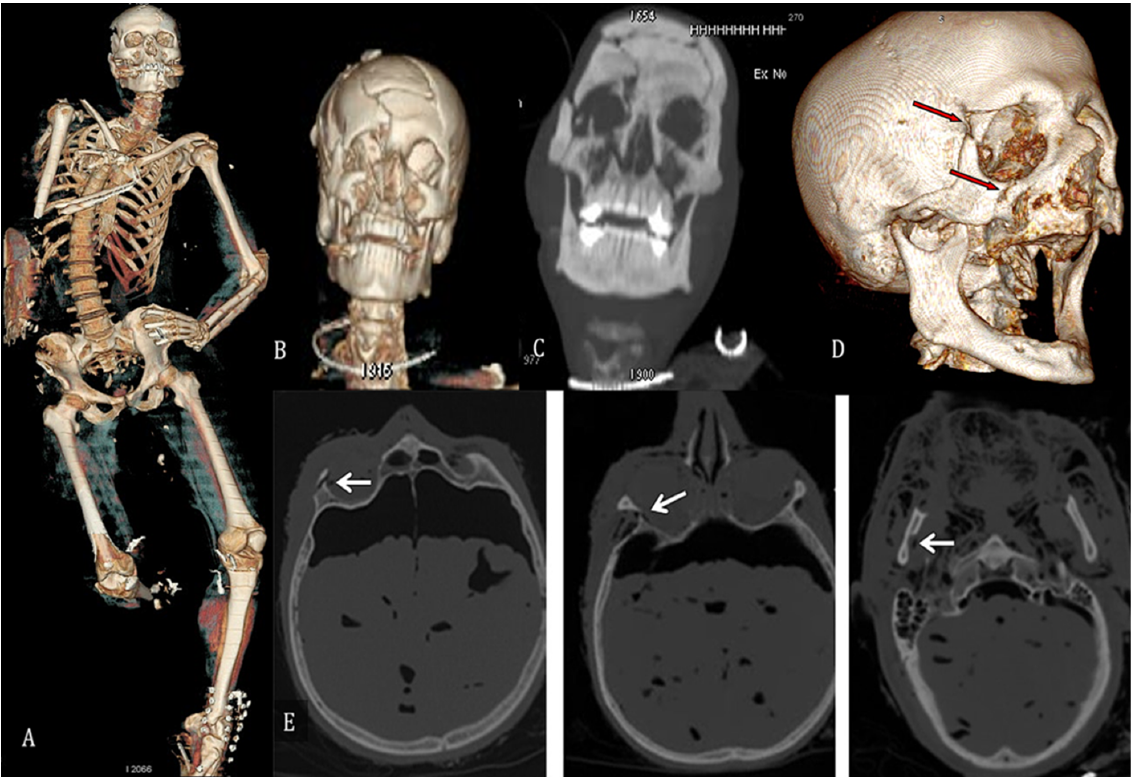
Figure 7. ( A ) Total body CT reconstruction on a partially charred corpse with the following features: heat fracture of the skull, fracture of the mandible, bilateral rib, sternal fractures, L4 and L5 body fractures, left fibula fracture, heat amputation of the right leg. ( B ) A 3D CT whole-body reconstruction in a cadaver with a facial mass fracture. ( C ) A CT whole body with skull and facial massive fractures. ( D – E ) Full body scan CT. Fracture of the right orbitofrontal process, fracture of the right zygomatic process, and fracture of the right mandibular body are seen on the skull. Autopsy examination was performed in 66 cases, 22 of which were burned bodies, while 43 were charred bodies. In only 16 cases was only an external examination per ‐ formed (14 cases of burned corpses and only 2 cases of charred corpses). Figure 8 shows some of the autoptic findings, such as a tongue covered with blackish material protrud ‐ ing from the oral cavity and trapped between the dental arches, or a thin extradural he ‐ matoma. The trachea and bronchi exhibited edematous and hyperemic cherry red muco ‐ sa with sooty residue inside and sooty fragments. As shown in Table 4, autoptic examination allowed the identification of vital lesions according to macroscopic criteria. Postmortem flame exposure was identified in 14 cases of charred cadavers, whereas in 12/26 cases the victim was alive when exposed to flame. Table 4. The table summarizes the autopsy examinations in 66/82 cases of charred bodies. Case